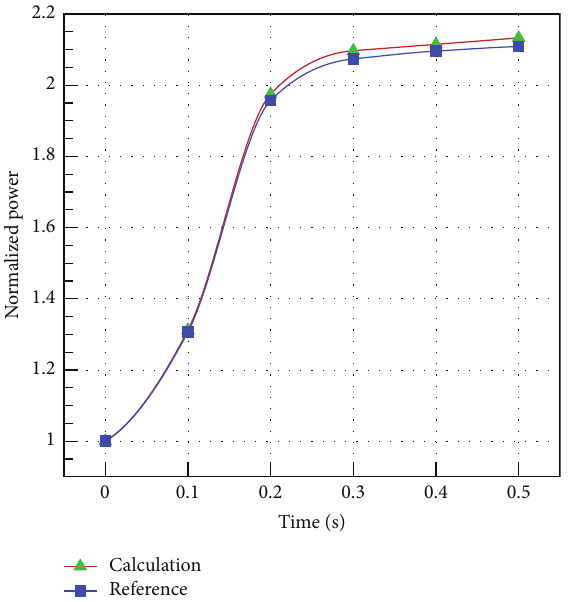
Figure4:NormalizedpowerversustimeinTWIGLproblemduring ramp perturbation.